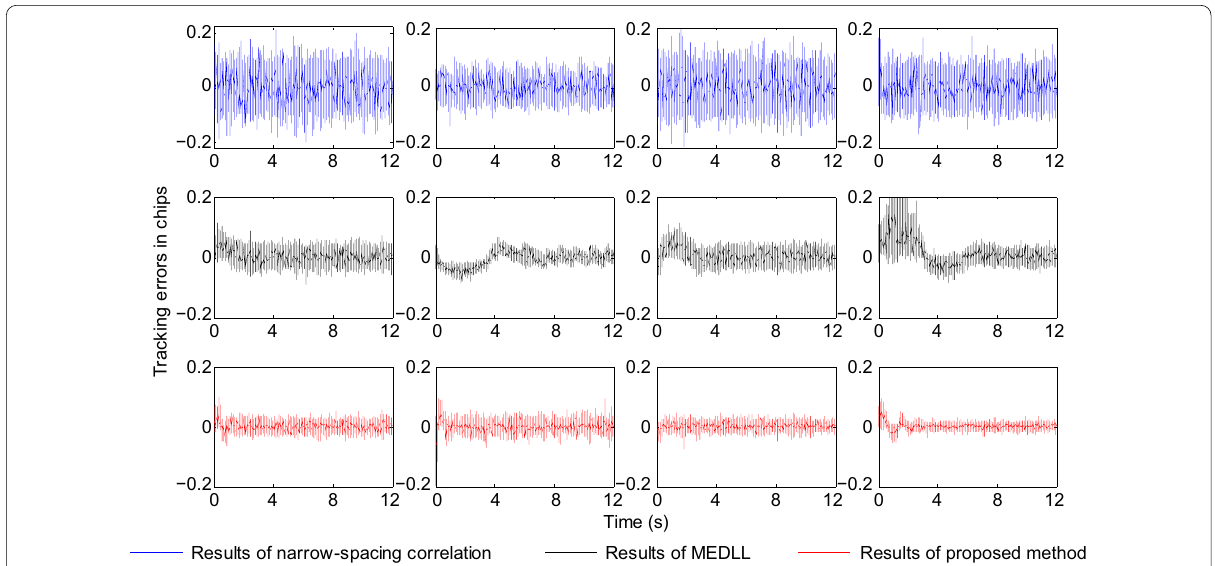
Results of narrow-spacing correlation Fig. 10 Tracking results. The first to fourth columns show the tracking results of PRN 3, 17, 19 and 22